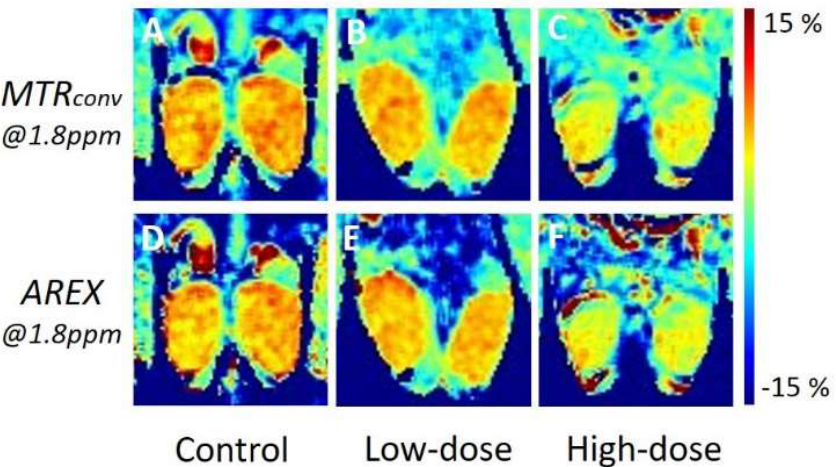
Figure 3. Representative in vivo Cr-CEST images of control and cisplatin-treated mice. The upper row displays the MTR asymmetry map of MTR conv at 1.8 ppm, whereas the bottom row displays the MTR asymmetry map of AREX . The left column represents the control ( A , D ), the central column represents the low dose ( B , E ), and the right column represents the high dose ( C , F ). MTR, magnetization transfer ratio; MTR conv , conventional analysis metric magnetization transfer ratio; AREX , apparent exchange- dependent relaxation; and Cr-CEST, creatine chemical exchange saturation transfer.